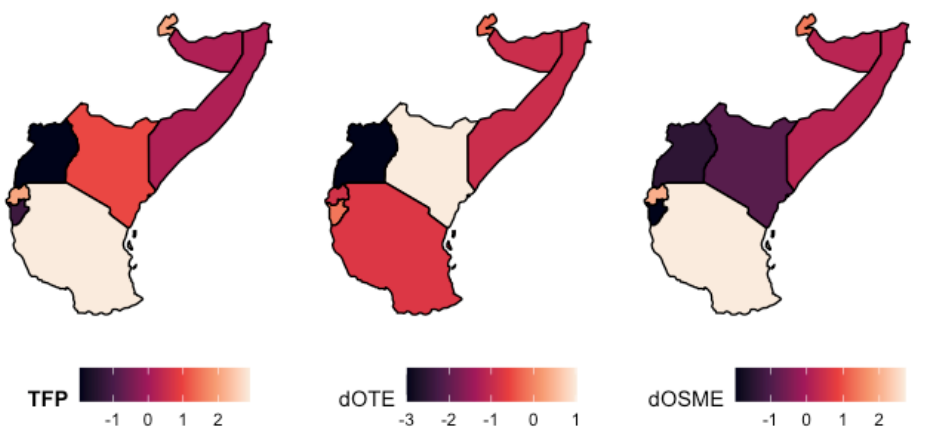
Figure 4. Agricultural productivity growth in East Africa as shown by TFP and components of TFPE, 2000–2016. Note: dTFP = Productivity Change, dOTE = Technical Efficiency Change and dOSME = Scale-Mix Efficiency.